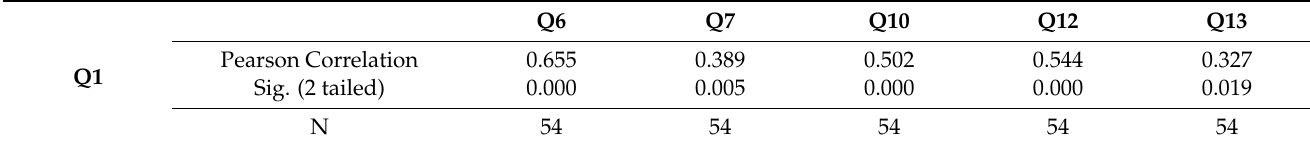
Table 3. Correlation between ethnic identification and